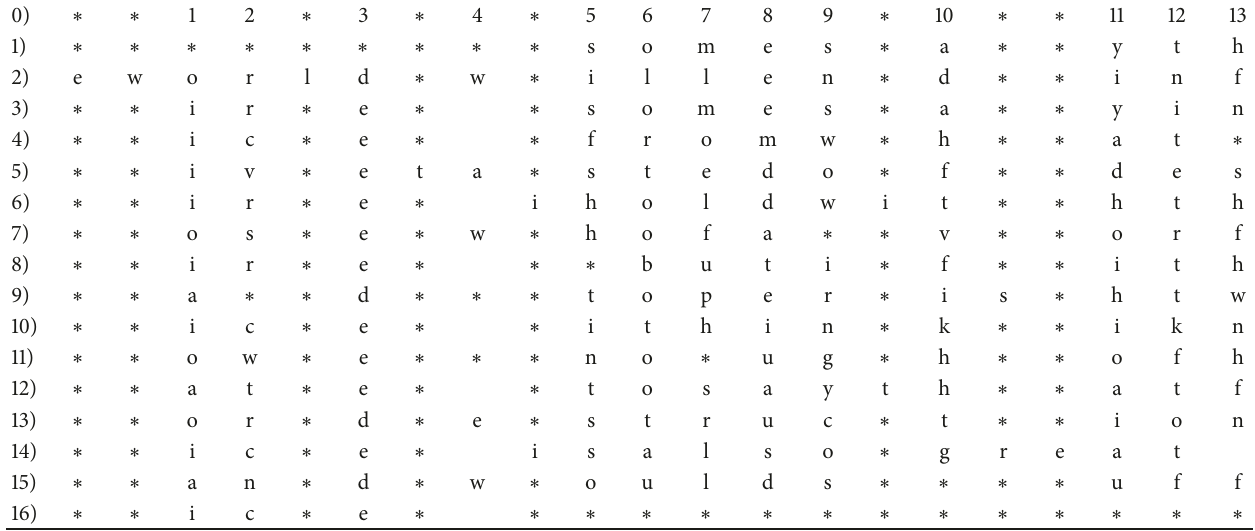
Table 2: Multiple alignment of Robert Frost’s poem “Fire and Ice.” The zero line shows the positions of the period.